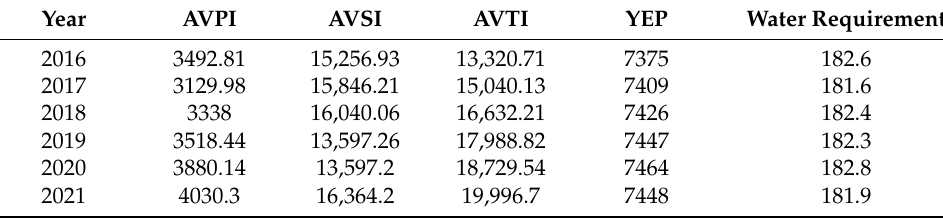
Table 4. Related data in Hebei Province.